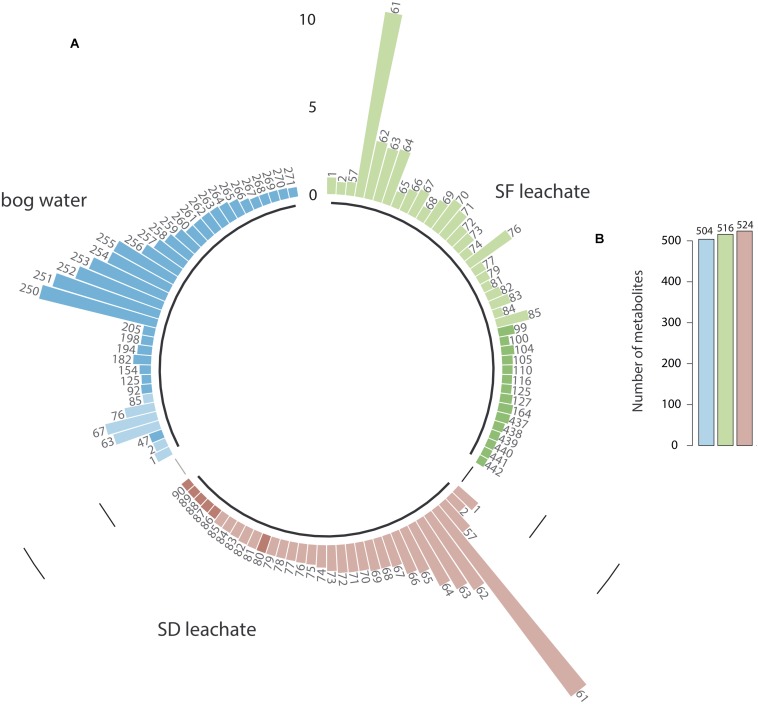
Relative abundance of metabolites in SF, SD leachates and bog water (A). Each bar and number correspond to a specific metabolite. For clarity of the graph, only the more concentrated metabolites are presented (relative abundance >2.5%). Dark-colored bars refer to metabolites that have a relative abundance higher than 2.5% in the considered extract, but less than 2.5% in other extracts. Total number of metabolites in SF, SD leachates and bog water are presented in (B).